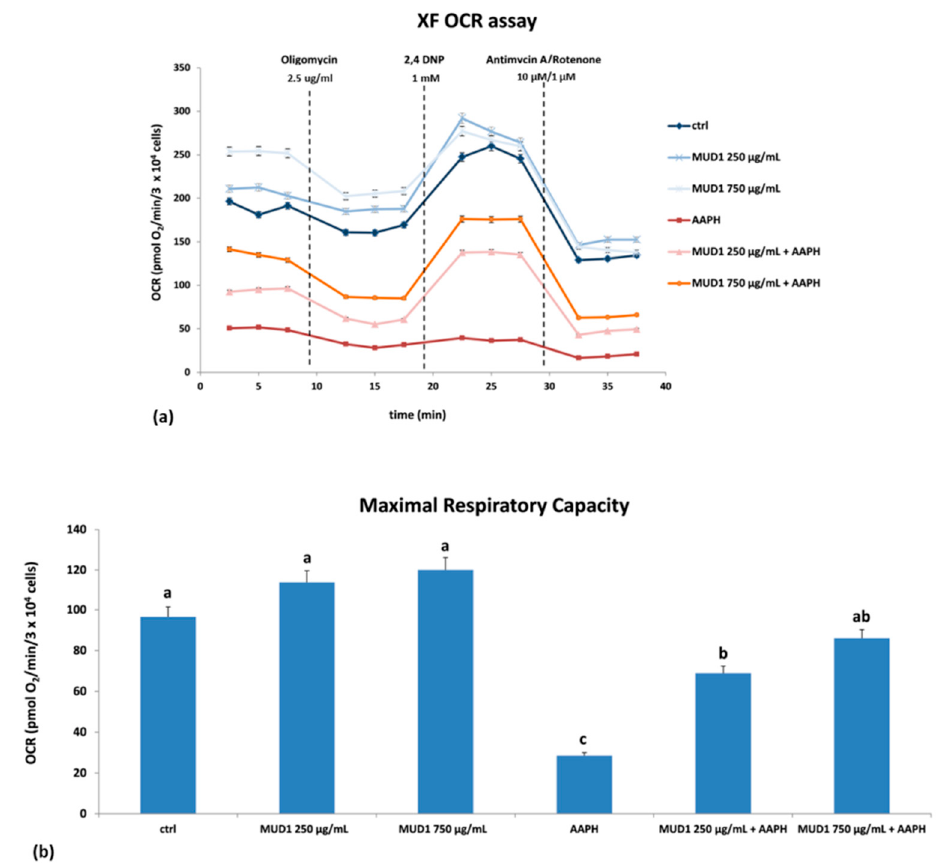
Figure 5. OCR ( a ) and maximal respiratory capacity ( b ) in HDF cells treated with different concentrations of MUD1 (250–750 µg/mL) for 24 h, AAPH (10 mM) for 24 h and with different concentrations of MUD1 and then with AAPH. Data are expressed as mean values ± SD. Columns belonging to the same set of data with different superscript letters are significantly different ( p < 0.05).